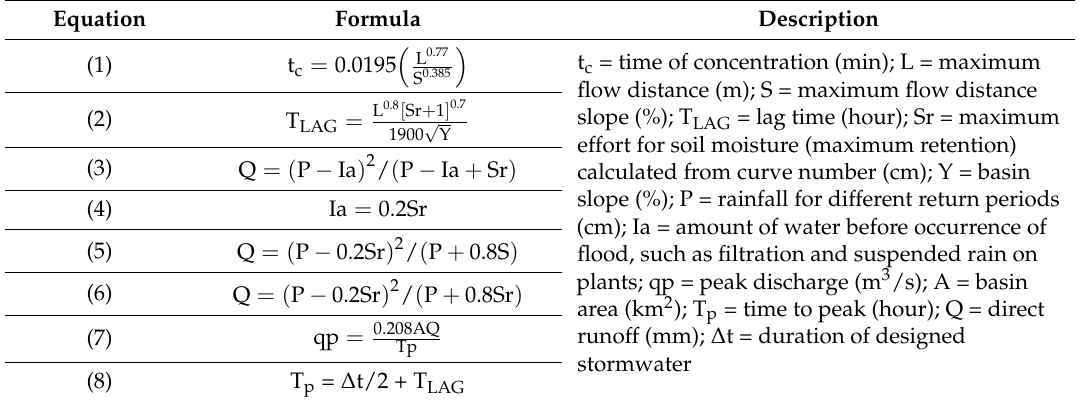
Table 1. Equations used in the current study.